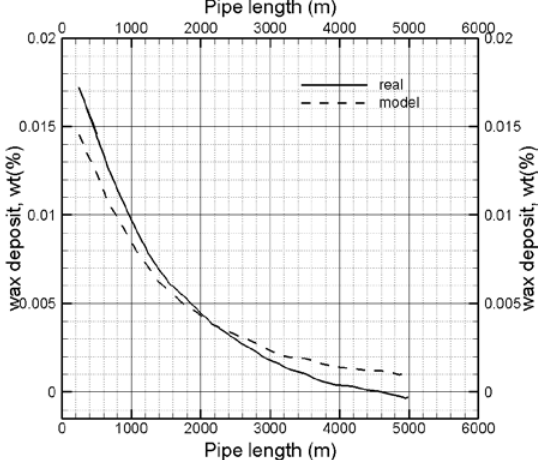
Figure 22 Comparison between real result and developed model for works by Gooya et al.